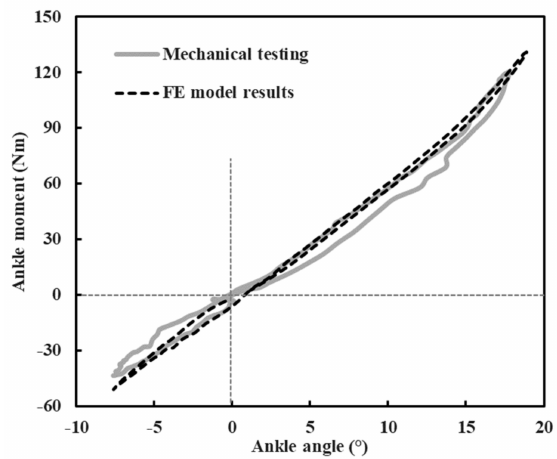
Figure 4. FE model validation. Ankle moment vs. ankle angle, measured values compared to results from the FE